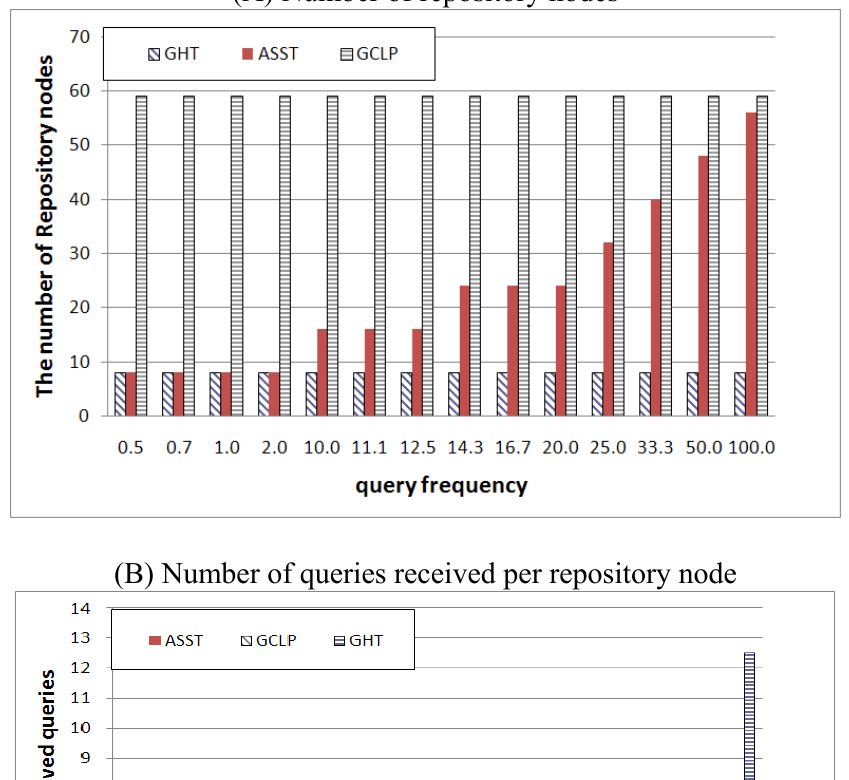
Figure 9. Number of repository nodes and the number of queries received per repository node. (A) Number of repository